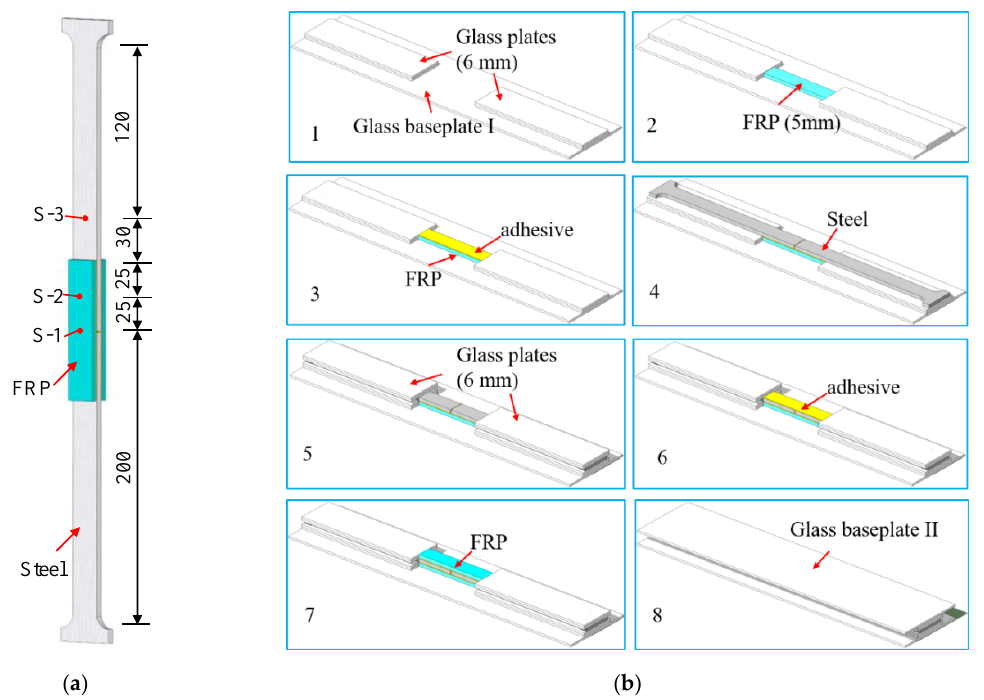
Figure 1. Dimensions of bonded specimen and bonding process (unit: mm). ( a ) Specimen; ( b ) Bonding Process.